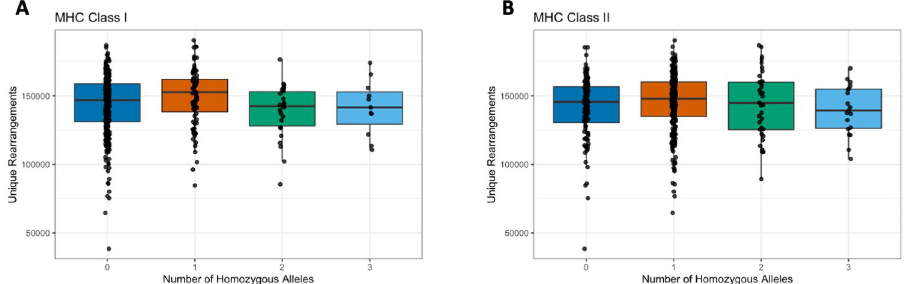
Fig 1. Correlation of TCR β repertoire richness and HLA zygosity. TCR β richness was quantified as the number of unique nucleotide rearrangements in a repertoire computationally down-sampled to 200,000 productive templates. HLA zygosity at neither (A) class I loci nor (B) class II loci correlated with diversity (Spearman rho = 0.035, p = 0.47 and rho = 0.021, p = 0.66 respectively).